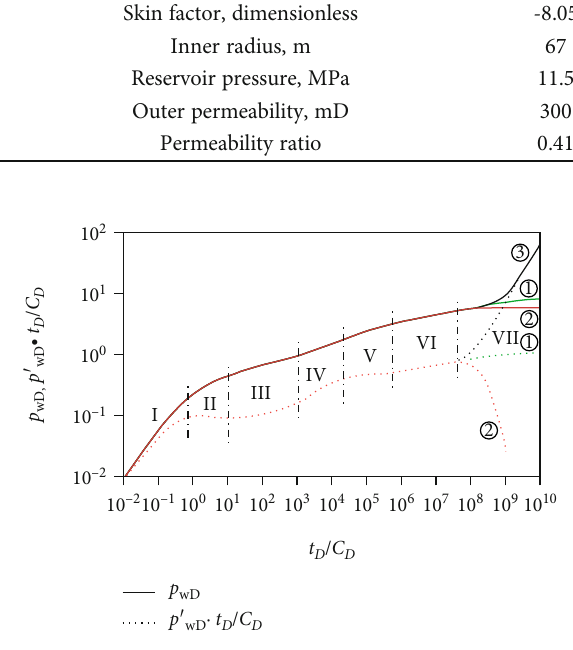
Figure 4: Typical pressure curves of bizonal composite